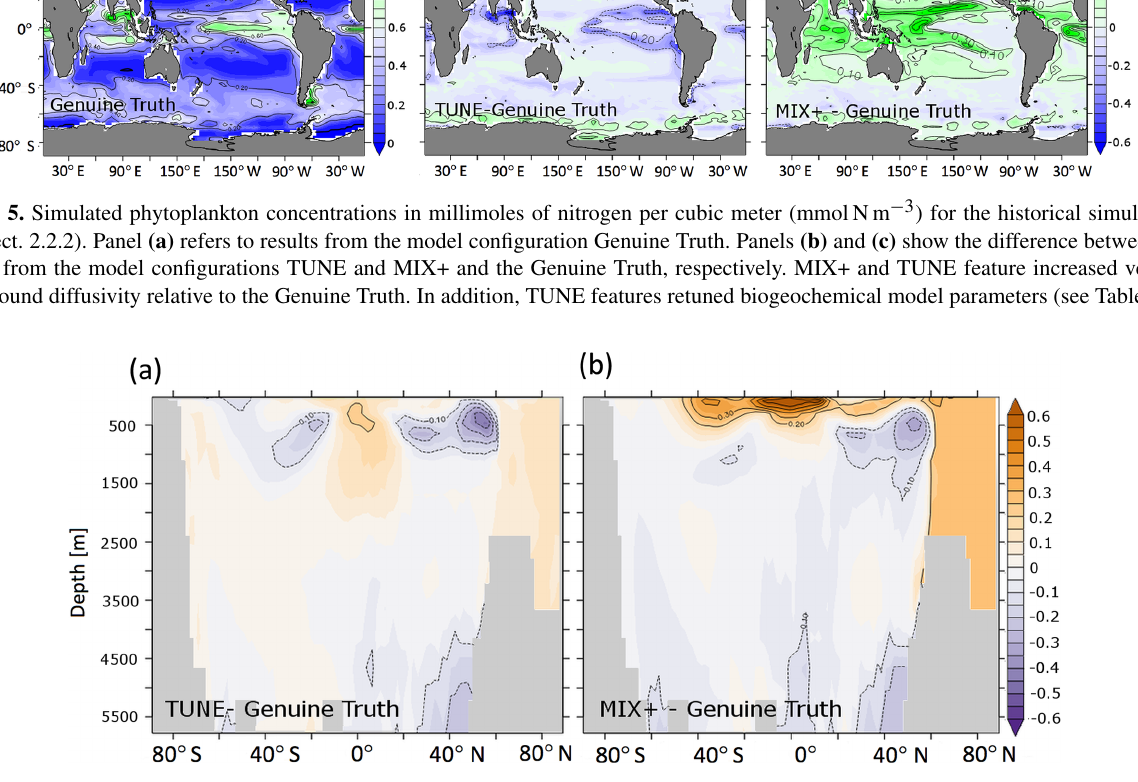
Figure 6. Differences between simulated meridionally averaged phosphate concentrations in millimoles of phosphate per cubic meter (mmolPm − 3 ) for the historical simulations (see Sect. 2.2.2). Panels (a) and (b) refer to TUNE minus Genuine Truth and MIX+ minus Genuine Truth,